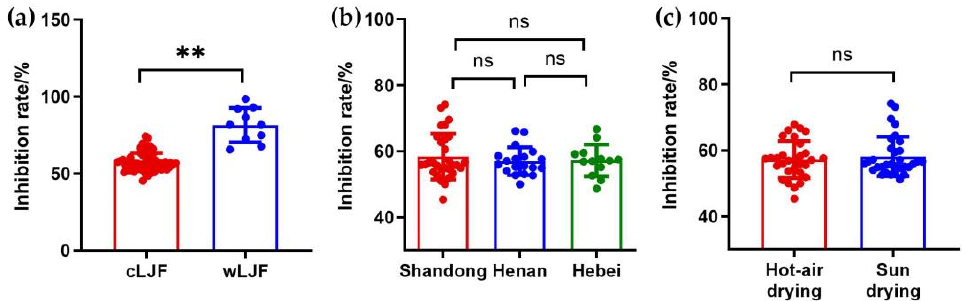
Figure 4. The NA inhibitory activity of LJF samples. ( a ) The NA inhibition rates of cLJF and wLJF samples. ( b ) The NA inhibition rates of cLJF samples from Shandong, Henan and Hebei. ( c ) The NA inhibition rates of cLJF samples processed by hot ‐ air drying and sun drying. (** p < 0.01, “ns” means “not significant”, p > 0.05, compared with each other.).